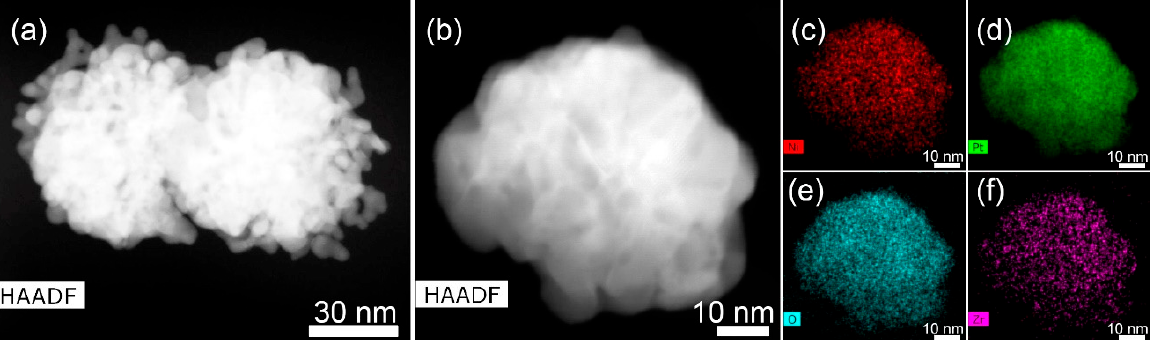
Figure 8. Elemental distribution in Pt agglomerates: STEM HAADF image of the agglomerates for samples 4 ( a ) and 5 ( b ); ( c – f ) corresponding elemental maps for sample 5 .